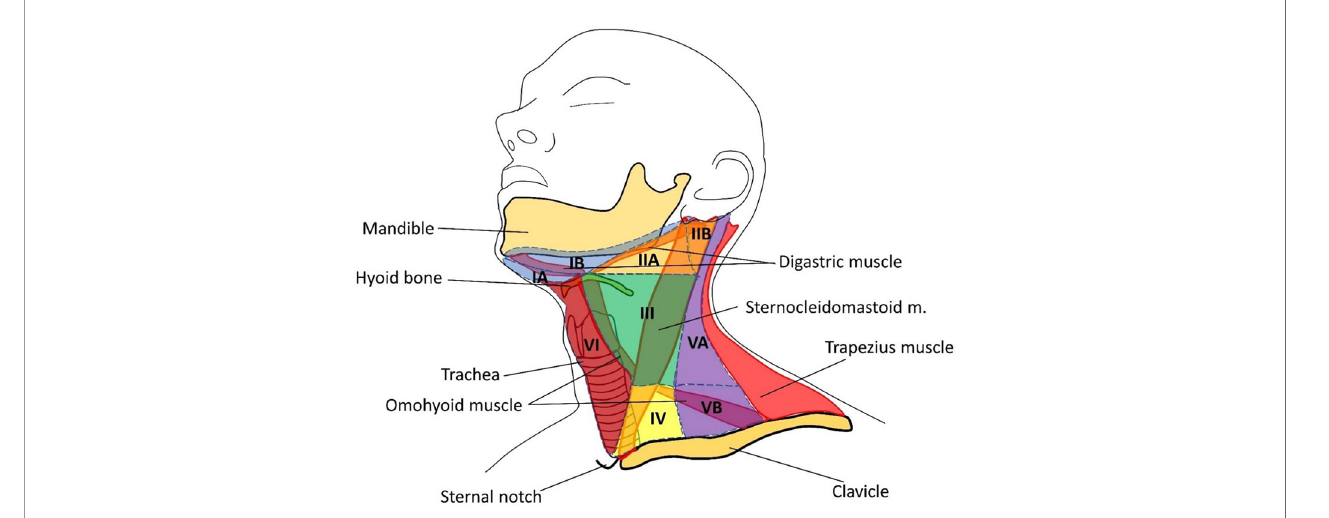
FIGURE 2 | Groups of cervical lymph nodes. I – below the body of the lower jaw; IA: group of chin nodes; IB: group of submandibular lymph nodes; II: upper jugular; IIA: upper jugular anterior; IIB: upper jugular posterior; III: middle jugular; IV: lower jugular; V: posterior (lateral) triangle of the neck; VA: accessory; VB: supraclavicular; VI: anterior space of the